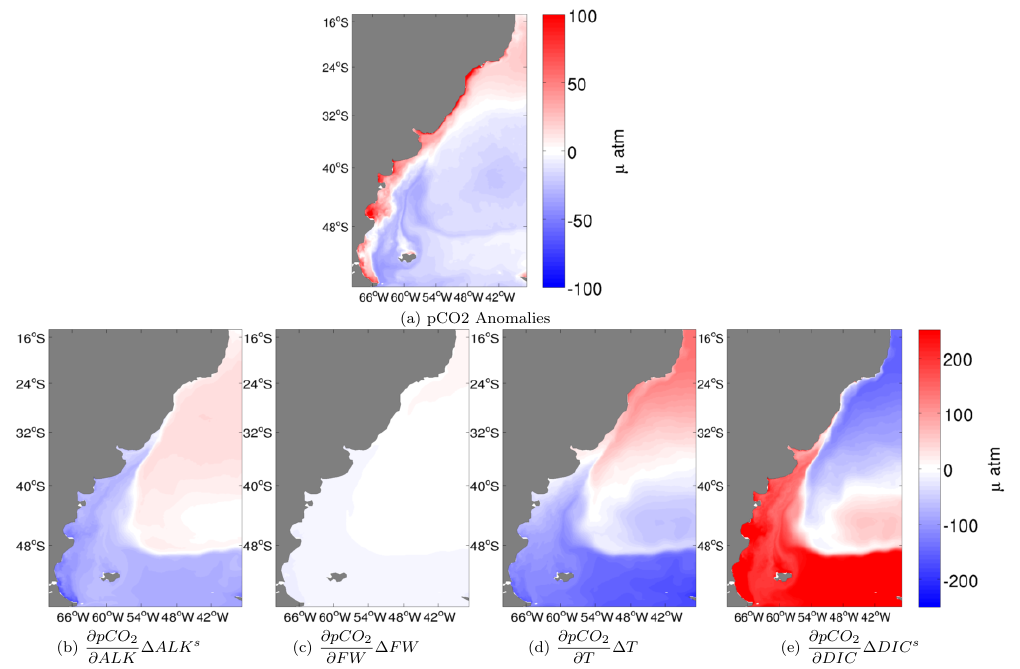
Figure 6. p CO 2 spatial anomalies – difference between annual mean and domain mean (a) and the contribution of the main drivers: ALK s (b) , FW (c) , T (d) and DIC s (e) . Computed using spatial anomalies for (cid:49)